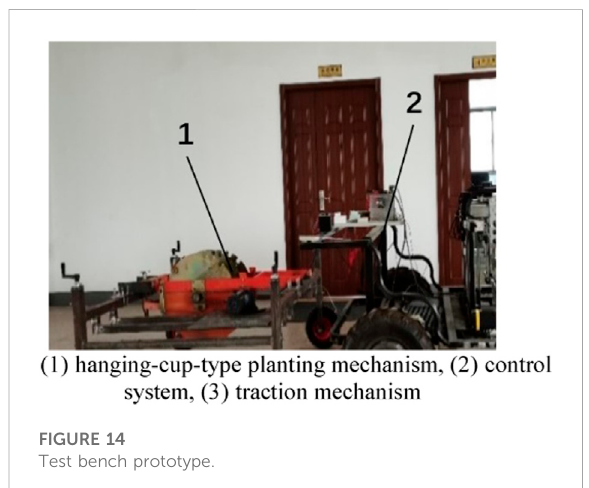
FIGURE 14 Test bench prototype.